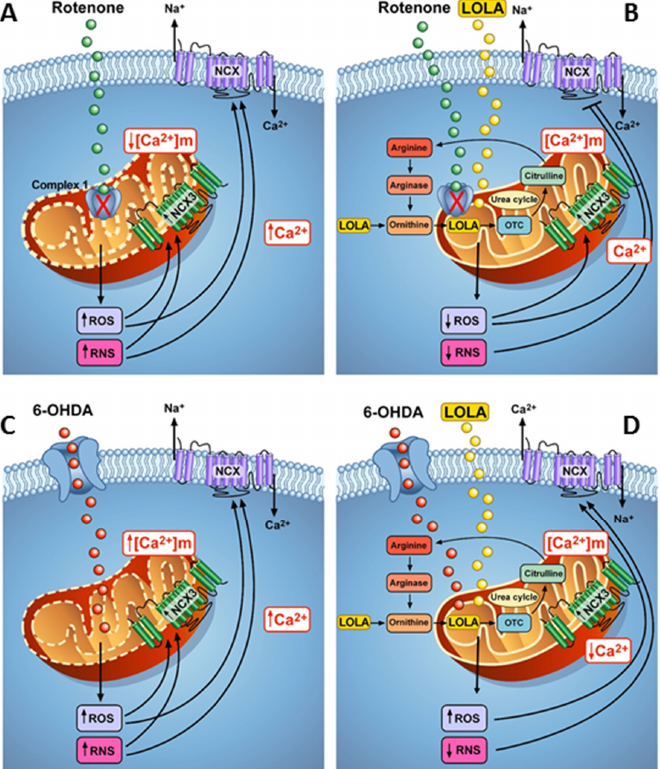
Figure 5. Schematic model of LOLA effects on mitochondrial activity and [Ca 2+ ] i in SH-SY5Y cells exposed to ROT and 6-OHDA. In cells treated with ROT ( A – C ), the increased ROS production causes the increase in intracellular calcium concentration probably due to the stimulation of ROS- sensitive NCX1 activity in the reverse mode of operation. These effects, associated with the block of mitochondrial complex I contributed to mitochondrial membrane depolarization and consequently mitochondrial dysfunction. In these conditions, the treatment with LOLA ( B – D ), by reducing ROS and NO production, improves mitochondrial function promoting mitochondrial calcium efflux through mitochondrial